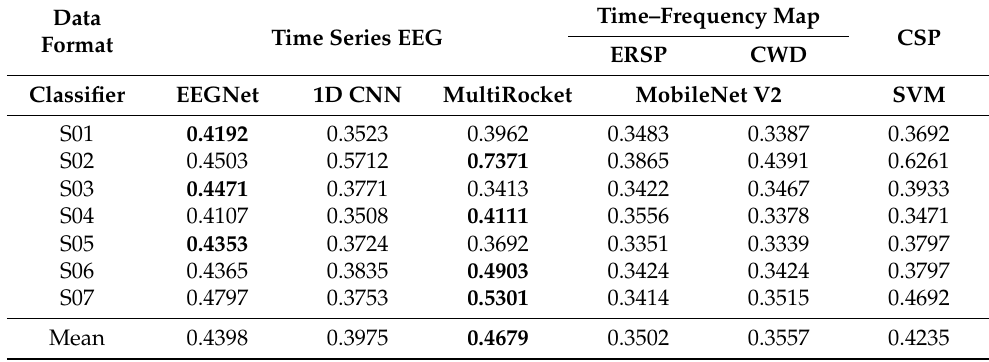
Table 5. Each subject’s classification accuracy of 3-category VI according to the data type and